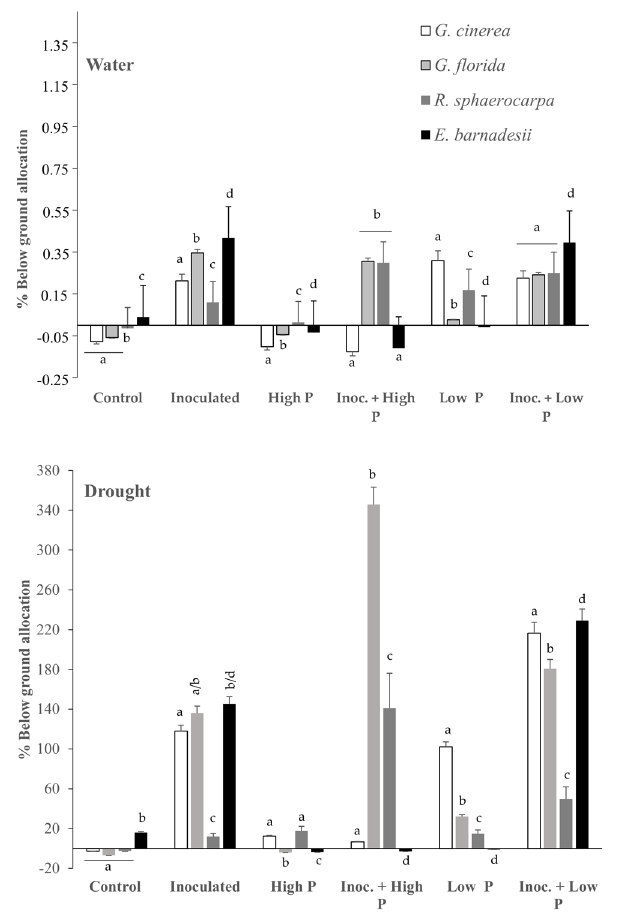
Figure 3. Percentage (%) of below-ground allocation of roots of G. cinerea , G. florida , E. barnadesii and R. sphaerocarpa plants supplied with high (500 µM) and low (5 µM) phosphorus, inoculated and non-inoculated under two water regimes (water and drought stressed). Values are presented as means ( n = 11–15) with standard error bars. The different letters indicate significant differences among the treatments ( p ≤ 0.05).